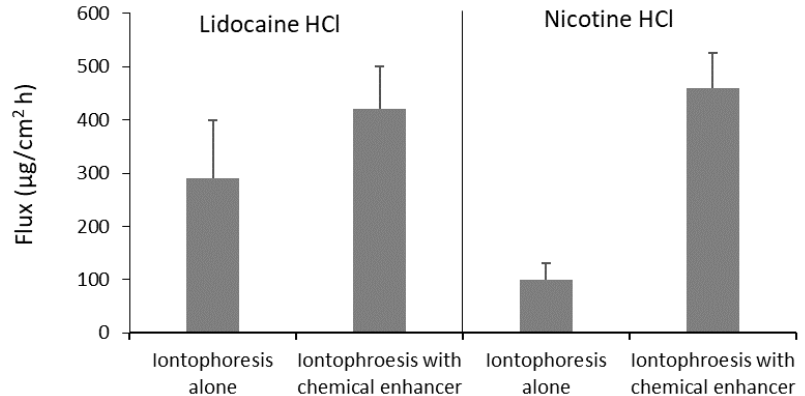
Figure 4. Lidocaine and nicotine fluxes of porcine buccal iontophoresis at 0.3 mA alone and with 5% dodecyl-2-( N , N -dimethylamino) propionate (DDAIP) as chemical enhancer. The combination of iontophoresis and chemical enhancer increases the fluxes of both drugs. Data from reference [73].